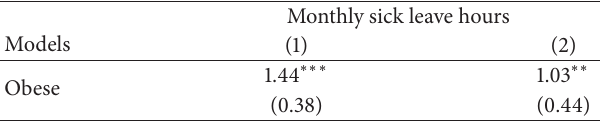
Table 4: The relationship between obesity and average monthly sick leave hours ( 𝑁 = 424 ).